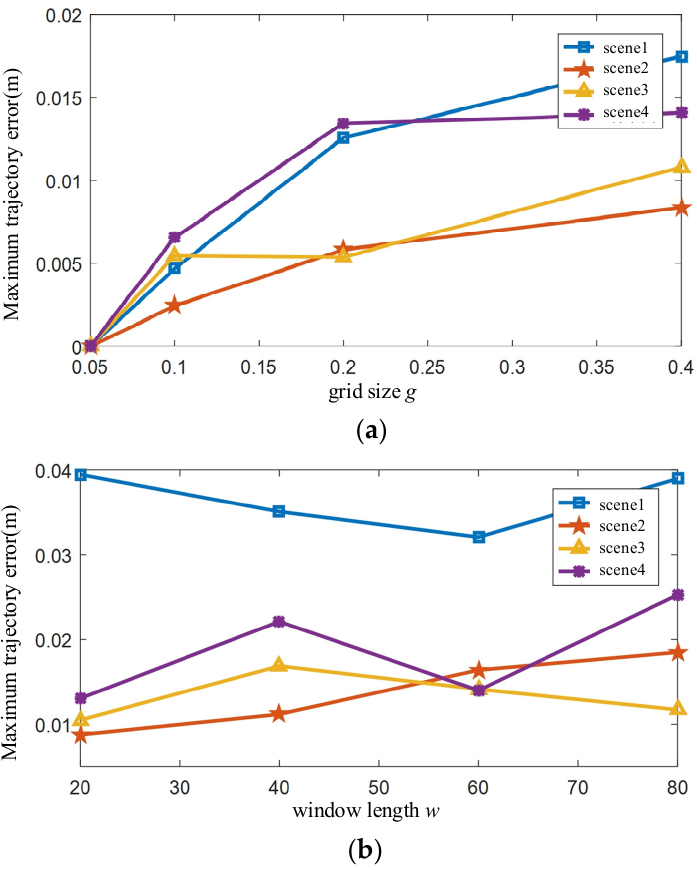
Figure 9. The influence of parameters on the trajectory. ( a ) grid size g . ( b ) window length w .